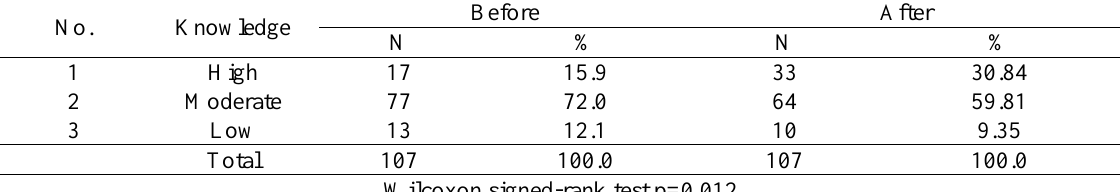
Table 1. Differences in knowledge of respondents pre- and post-intervention